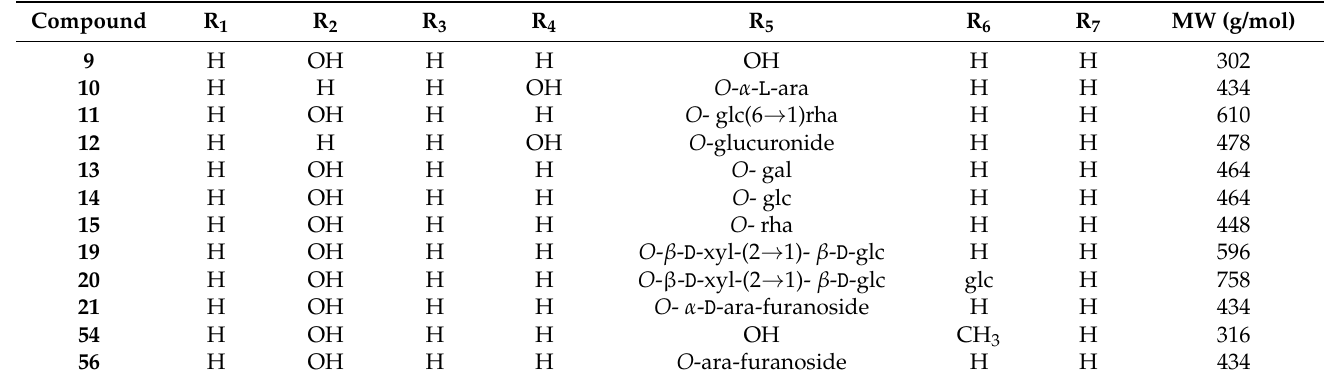
Table 2. Quercetin and derivatives.